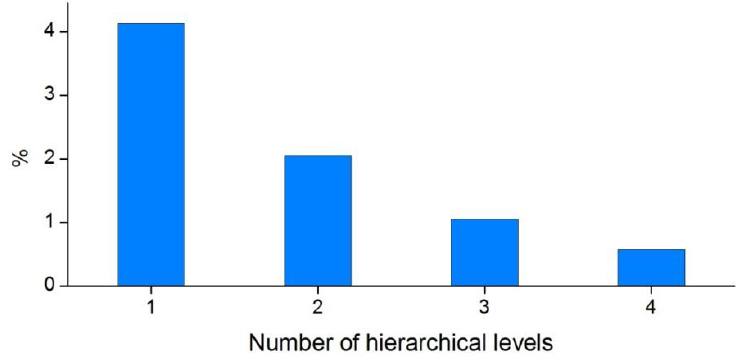
Figure 5. The percentage of processed nodes in graph search performed using the HPA* method with different number of hierarchical levels compared to the traditional, nonhierarchical method. The base block size is 10 × 10